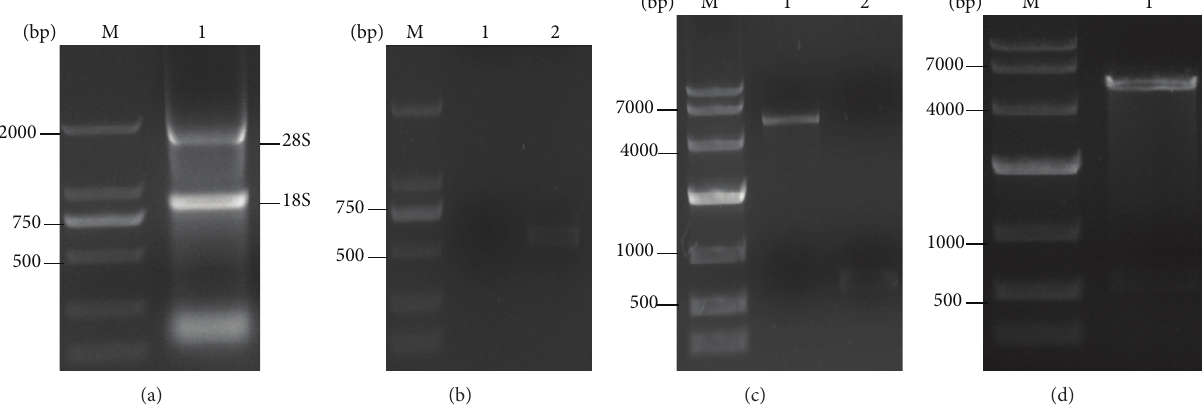
Figure 4: Construction and verification of the P-gp recombinant. (a) The total RNA of human colorectal cancer, M: DL2000 DNA marker; lane 1: total RNA of human colorectal cancer. (b) PCR amplification of P-gp 21 gene, M: DL2000 DNA Marker; lane 1: blank control; lane 2: target gene of P-gp 21 . (c) pET28a (+) and P-gp 21 gene digested by EcoR I/Xho I double enzyme, M: DL10000 DNA Marker; lane 1: the digested pET28a (+); lane 2: the digested P-gp 21 target gene. (d) Positive clone of P-gp 21 verified by double-enzyme cleavage, M: DL10000 DNA Marker; lane 1: positive clone of P-gp 21 .